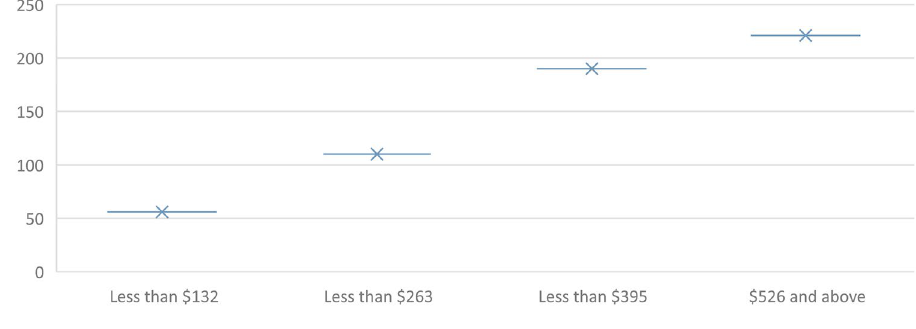
Fig. 4 Solar Energy as an Alternative Means of Energy to Electricity from the National Grid. Source: